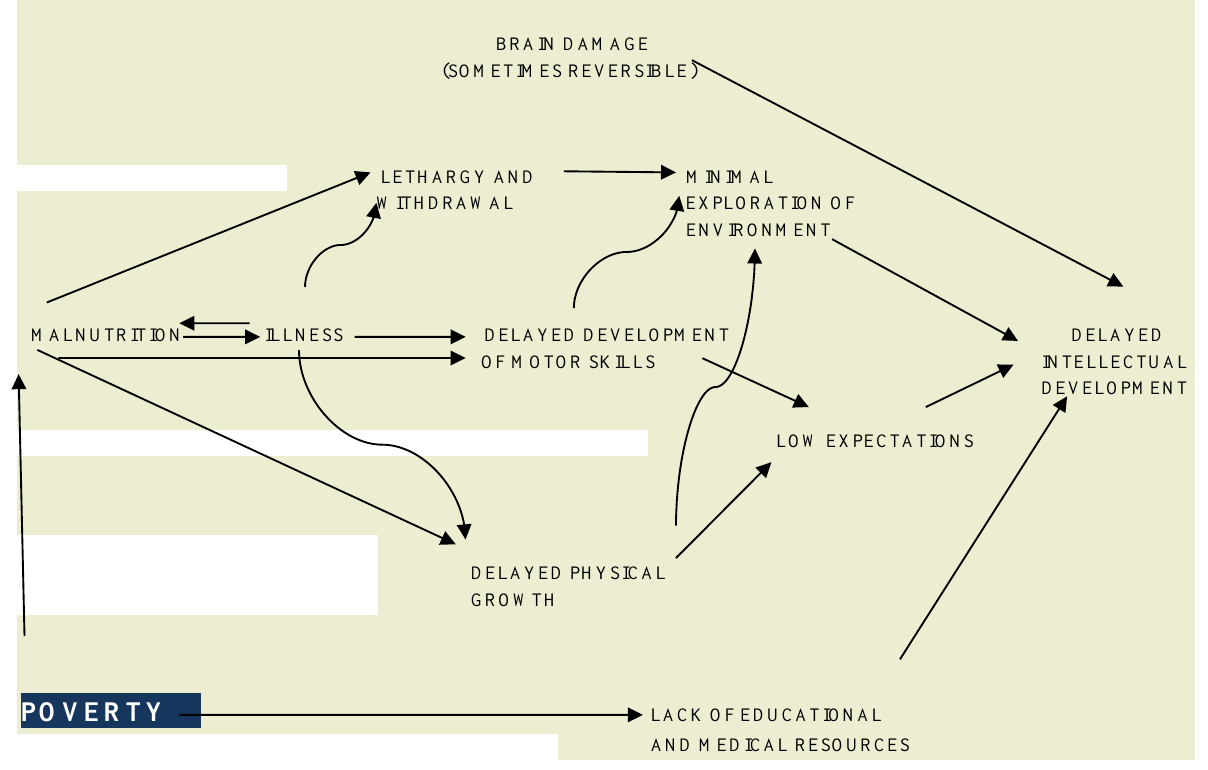
Figure 3.1: How malnutrition hinders cognitive development (Pollitt & Brown,